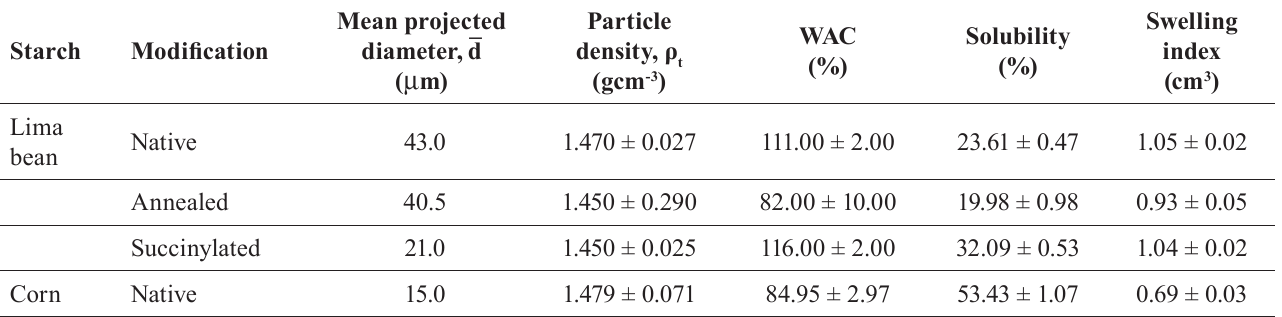
TABLE II - Physicochemical properties of the starches